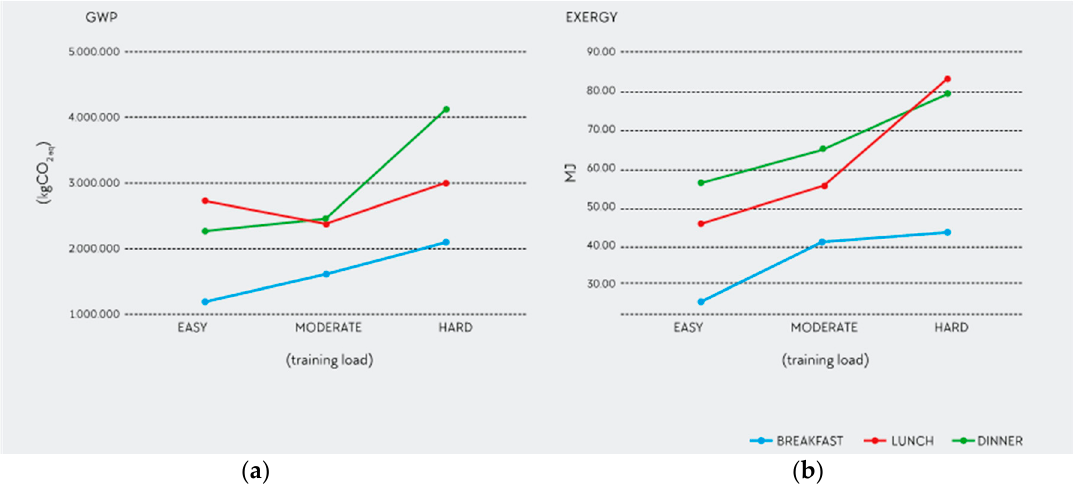
Figure 6. Two-way interaction for GWP and exergy: ( a ) GWP . Female two-way interaction (meal × training load) for GWP. ( b ) Exergy . Male two-way interaction (meal × training load) for exergy.